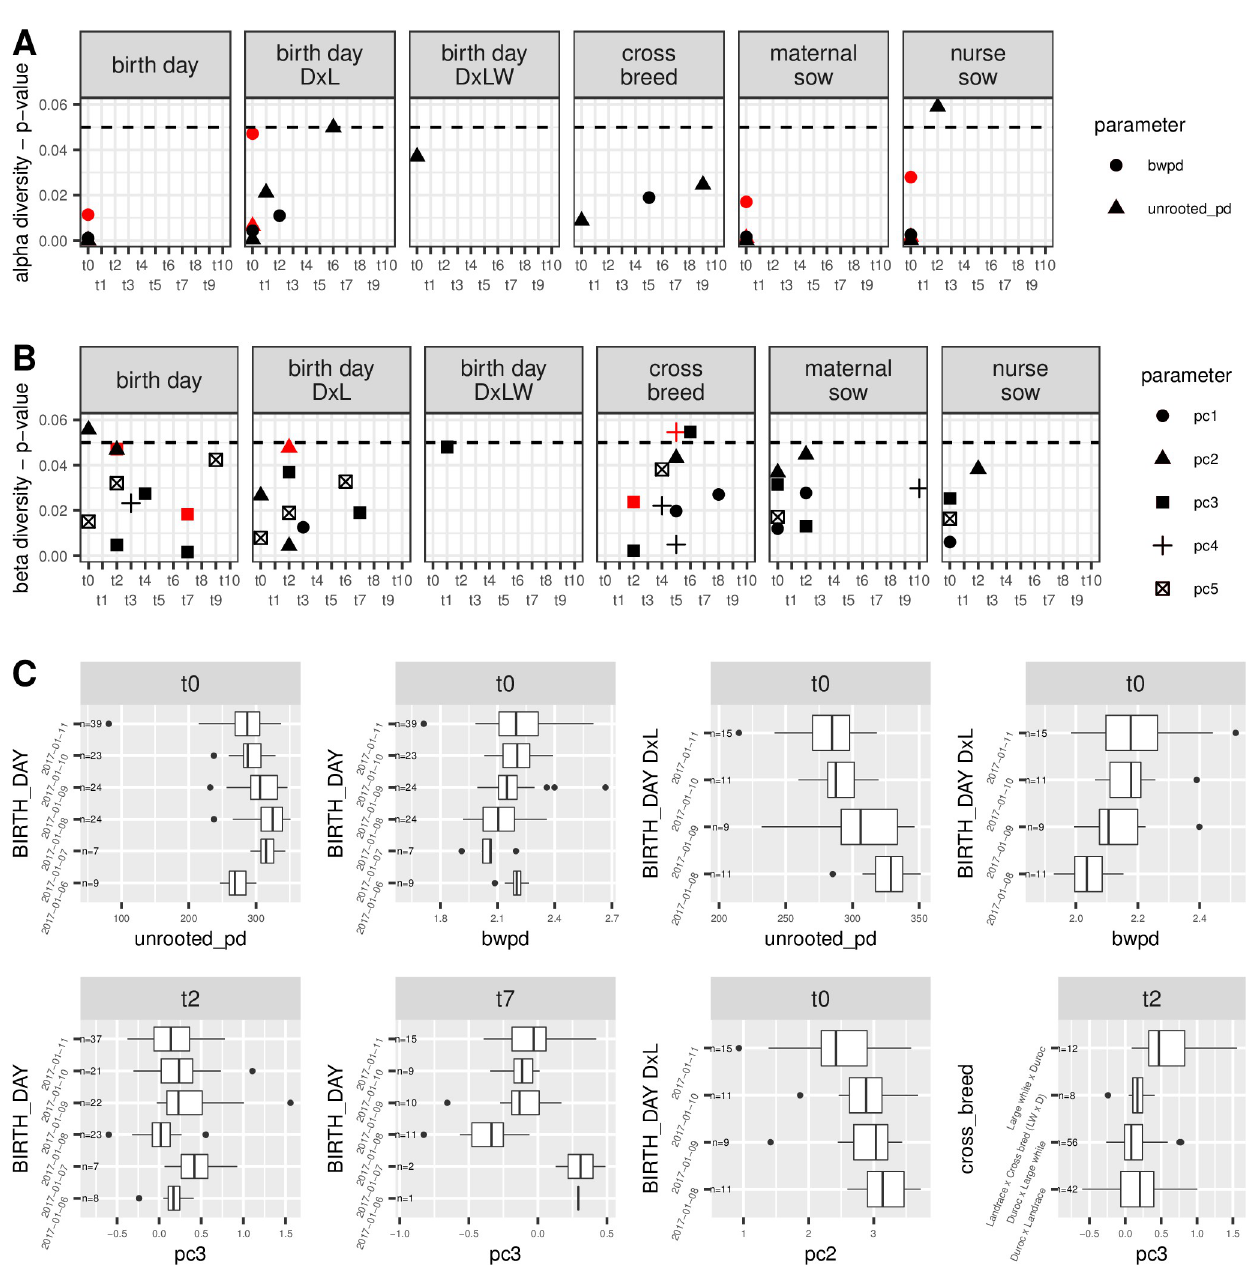
Fig 2. Significant correlations of phylogenetic diversity with specified host factors. The correlation of host factors birth day, cross-breed, birth day within the D × L cross-breed, birth day within the D × LW cross-breed, litter (maternal sow and nurse sow) with alpha phylogenetic diversity ( A ) and beta phylogenetic diversity ( B ) from each time point (x-axes) was obtained. Shown in A and B are the significance values of these correlations derived from Kruskal-Wallis analysis, where the symbol shape indicates the phylogenetic diversity measure of alpha (unrooted pd and BWPD) and beta (PC components 1 to 5), while the symbol color indicates the significance before (black) and after (red) Hommel p value adjustment. C) For each red symbol in A and B, describing a significant correlation after Hommel p value adjustment, a plot of the phylogenetic diversity estimates is shown. Phylogenetic diversity estimates of the litter effect are not shown. All p values are reported (S1 Table, sheets: “all_pvalues” and “all_padj_Hommel). Abbreviations: D × L = “Duroc × Landrace” cross breed; D × LW = “Duroc × Large White” cross breed. Hommel adjusted p values, a similarity of alpha phylogenetic diversity can be seen among pig- lets from the same maternal sow (unrooted PD: p = 0.001; BWPD: p = 0.017) and in piglets from the same nurse sow (unrooted PD: p = 0.002; BWPD: p = 0.027) (Fig 2; S1 Table, sheet: